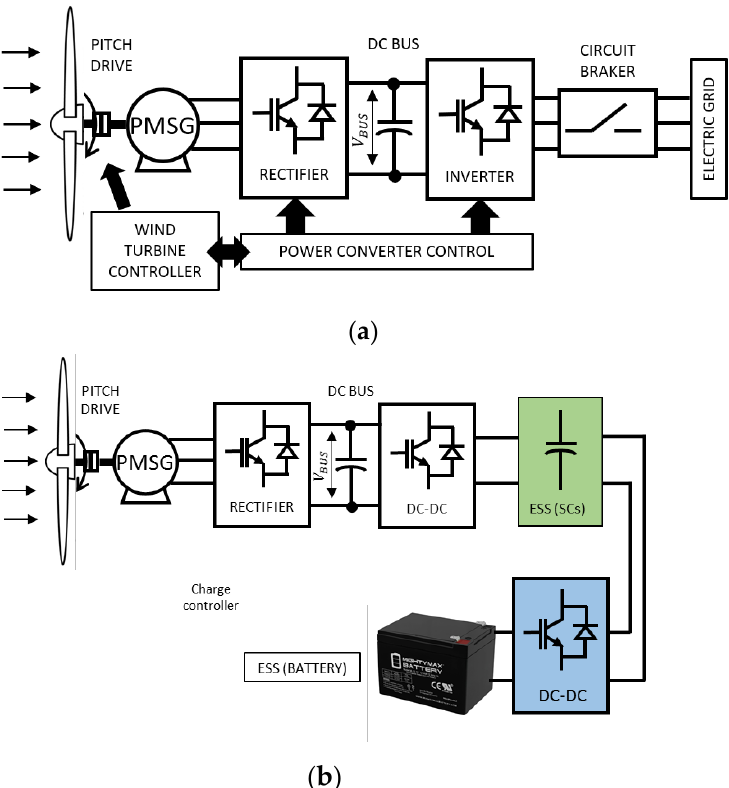
Figure 14. ( a ) Simplified electrical diagram of a variable speed wind turbine with full-scale power converter; ( b ) Wind Energy Conversion System with proposed HESS adapted from [60].